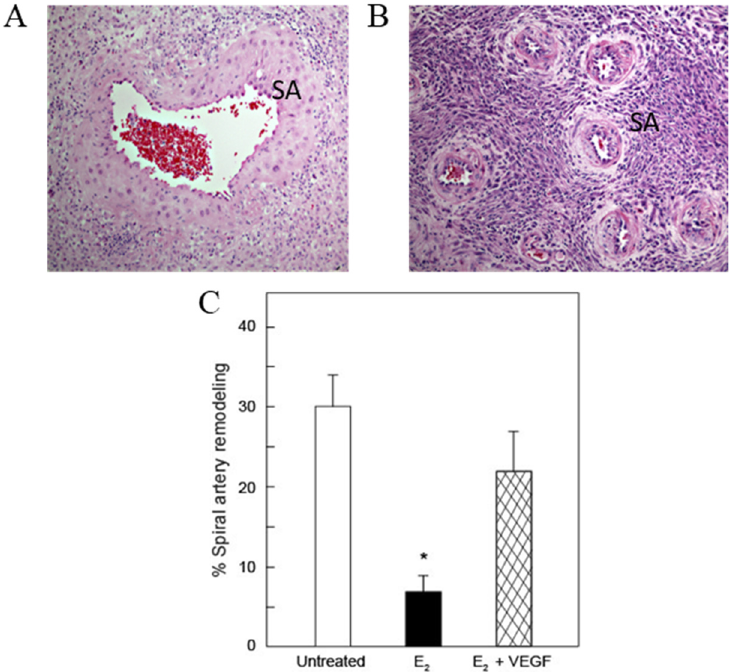
Figure 6. Photomicrographs of H & E histology of the basal plate and spiral arteries (SA) in un- treated ( A ) and estradiol-treated ( B ) baboons. ( C ) Mean (± SE) percentage of uterine spiral arteries remodeled (i.e., number of trophoblast invaded arteries divided by total number of arteries counted), as quantified by image analysis, for vessels greater than 50 µM in diameter on day 60 of gestation in untreated ( n = 13), estradiol (E 2 )—treated ( n = 15) and E 2 plus VEGF gene-treated ( n = 6) baboons. * p < 0.001 versus untreated and E 2 plus VEGF gene treated animals. Modified from [82].